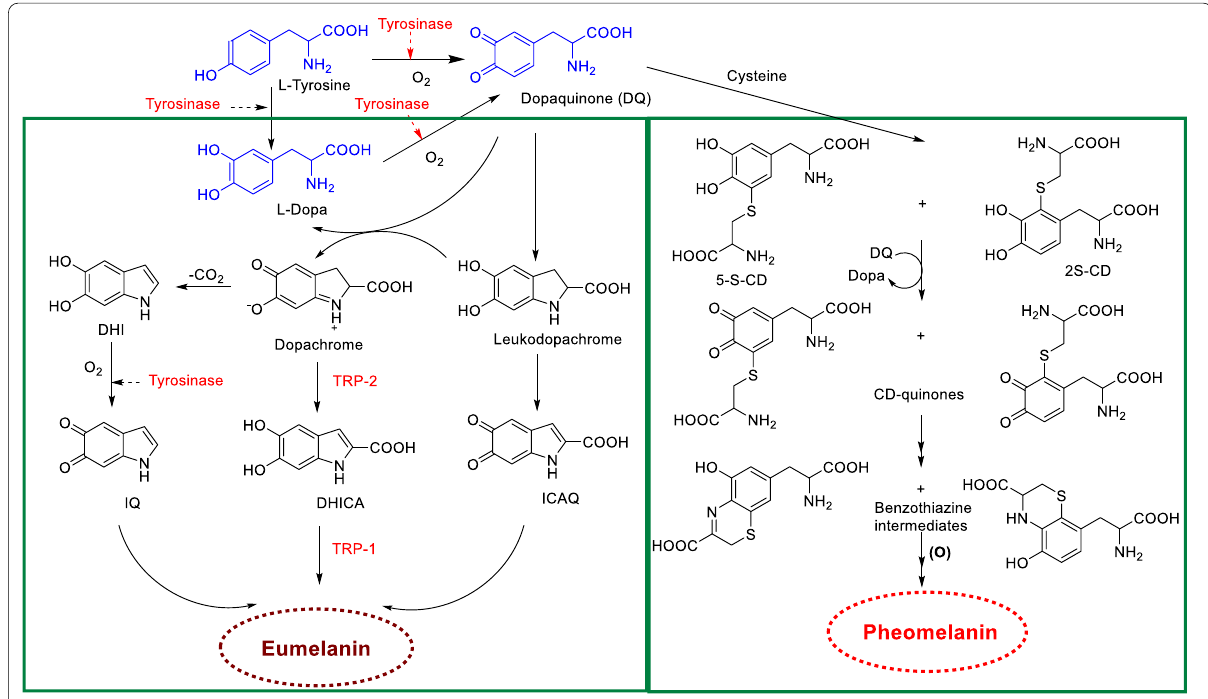
Fig. 1 The pathway for the production of melanin: tyrosinase‑related protein 1(TRP‑1); tyrosinase‑related protein 2 (TRP‑2); 5,6‑dihydroxyindol (DHI); indole‑5,6‑quinone (IQ); 5,6‑dihydroindole‑2 (DHICA); indole‑2‑carboxylic acid‑5,6‑quinone (ICAQ); 5‑S‑cysteinyldopa (5‑S‑CD); 2‑S‑cysteinyldopa